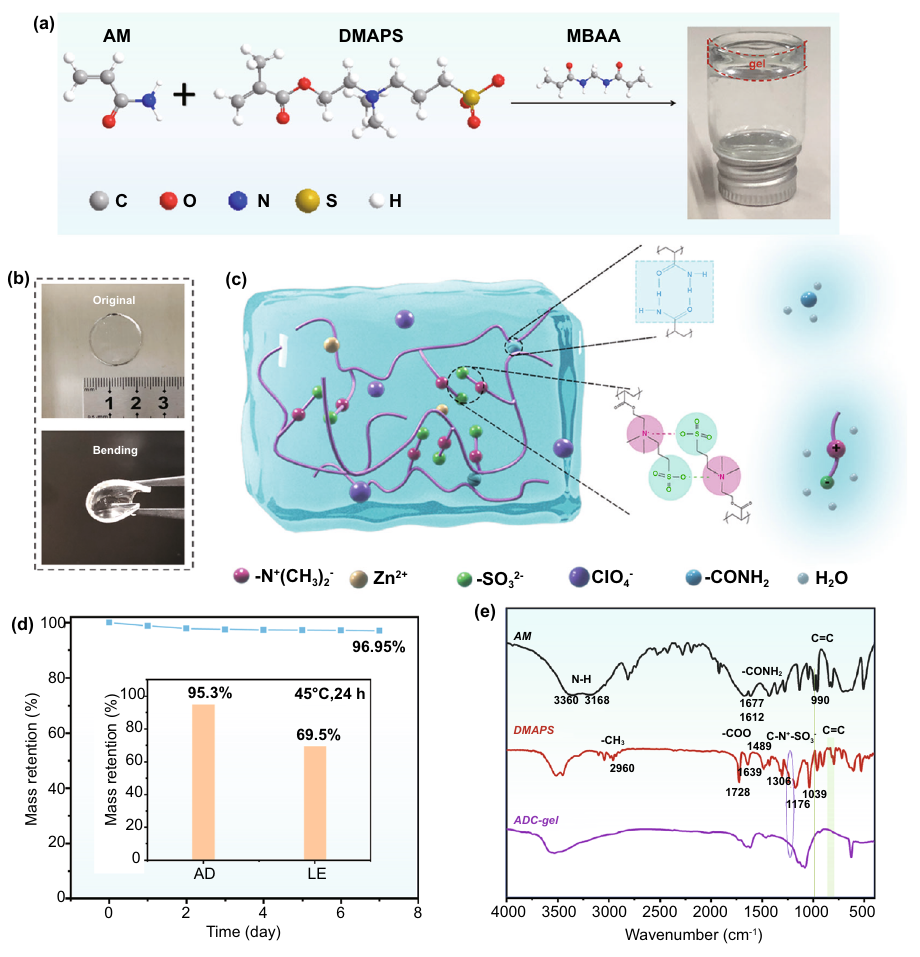
Fig. 1 a Schematic diagram of the synthesis path of the ADC-gel under thermal initiation. b Optical images of the ADC-gel electrolyte with bending characteristic. c Schematic of the interaction in the ADC-gel matrix. d Mass retention capacity of the ADC-gel when exposed to differ- ent temperatures under ambient environment. e FTIR spectra of the monomers (AM and DMAPS) and the hydrogel